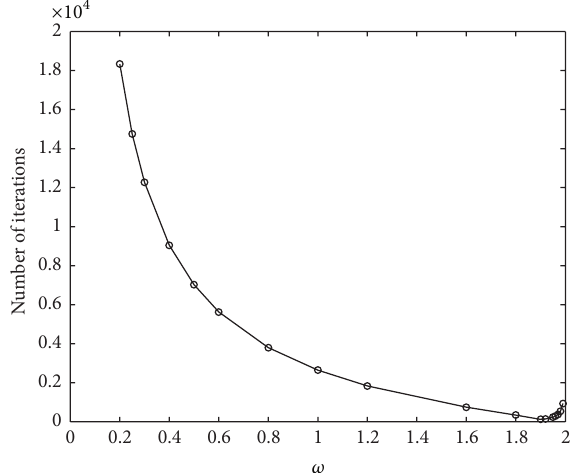
Figure 2: Numbers of iterations and 𝜔 values for Example